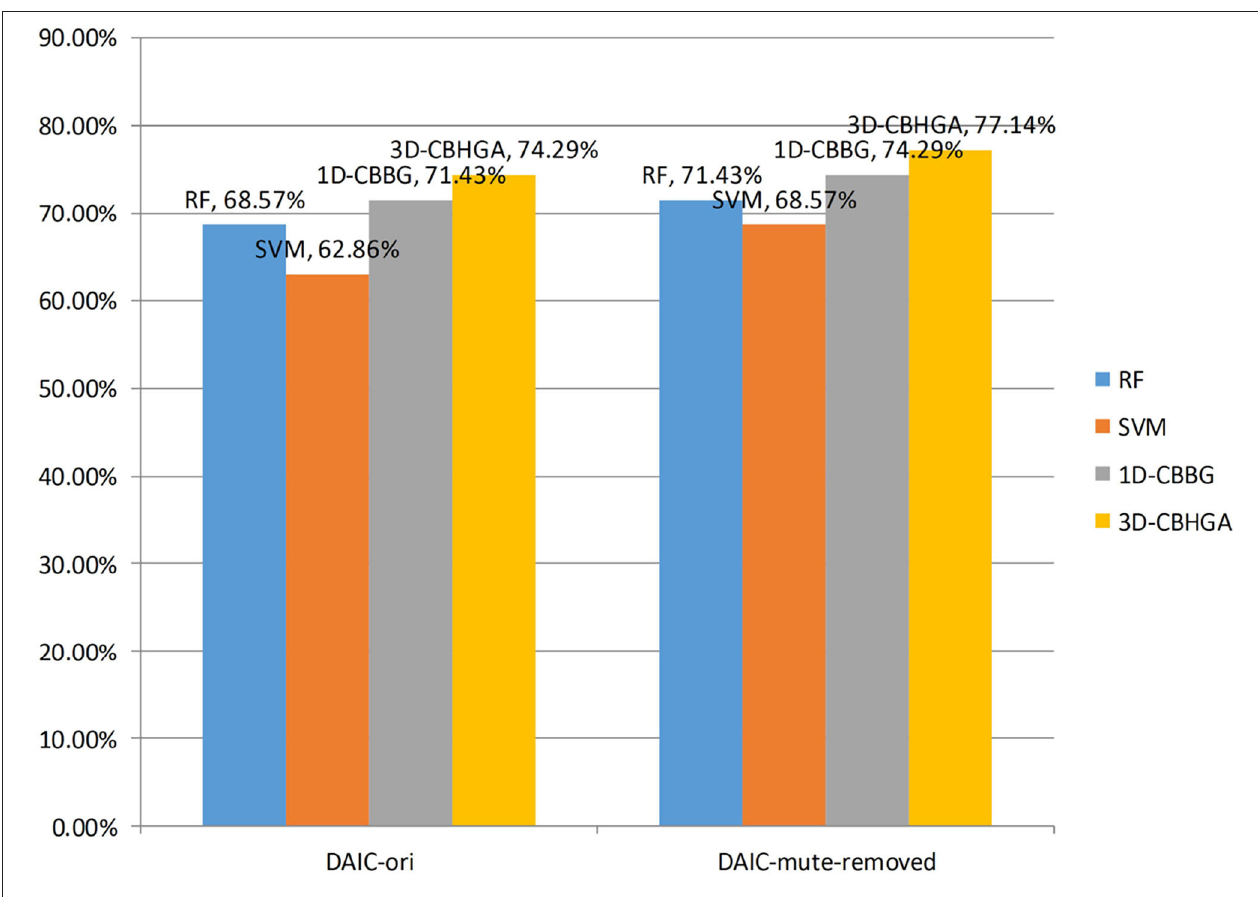
FIGURE 11 | Accuracy of different